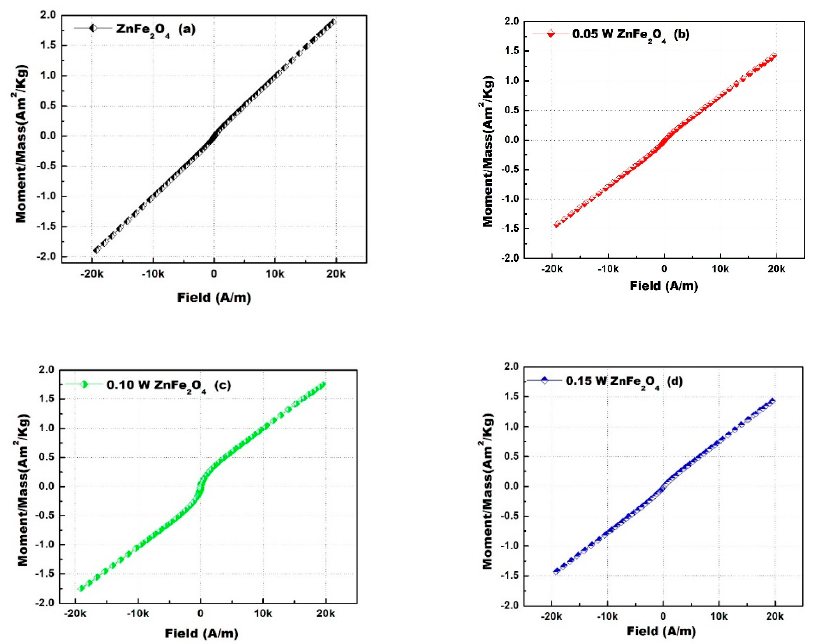
Figure 8. H-M hysteresis loops of ( a ) ZnFe 2 O 4 , ( b ) ZnW 0.05 Fe 1.95 O 4 , ( c ) ZnW 0.1 Fe 1.90 O 4 , and ( d ) ZnW 0.15 Fe 1.85 O 4 . Table 3. The magnetization of the ZnW x Fe 2 − 2x O 4 samples at 20 kA/m. Samples